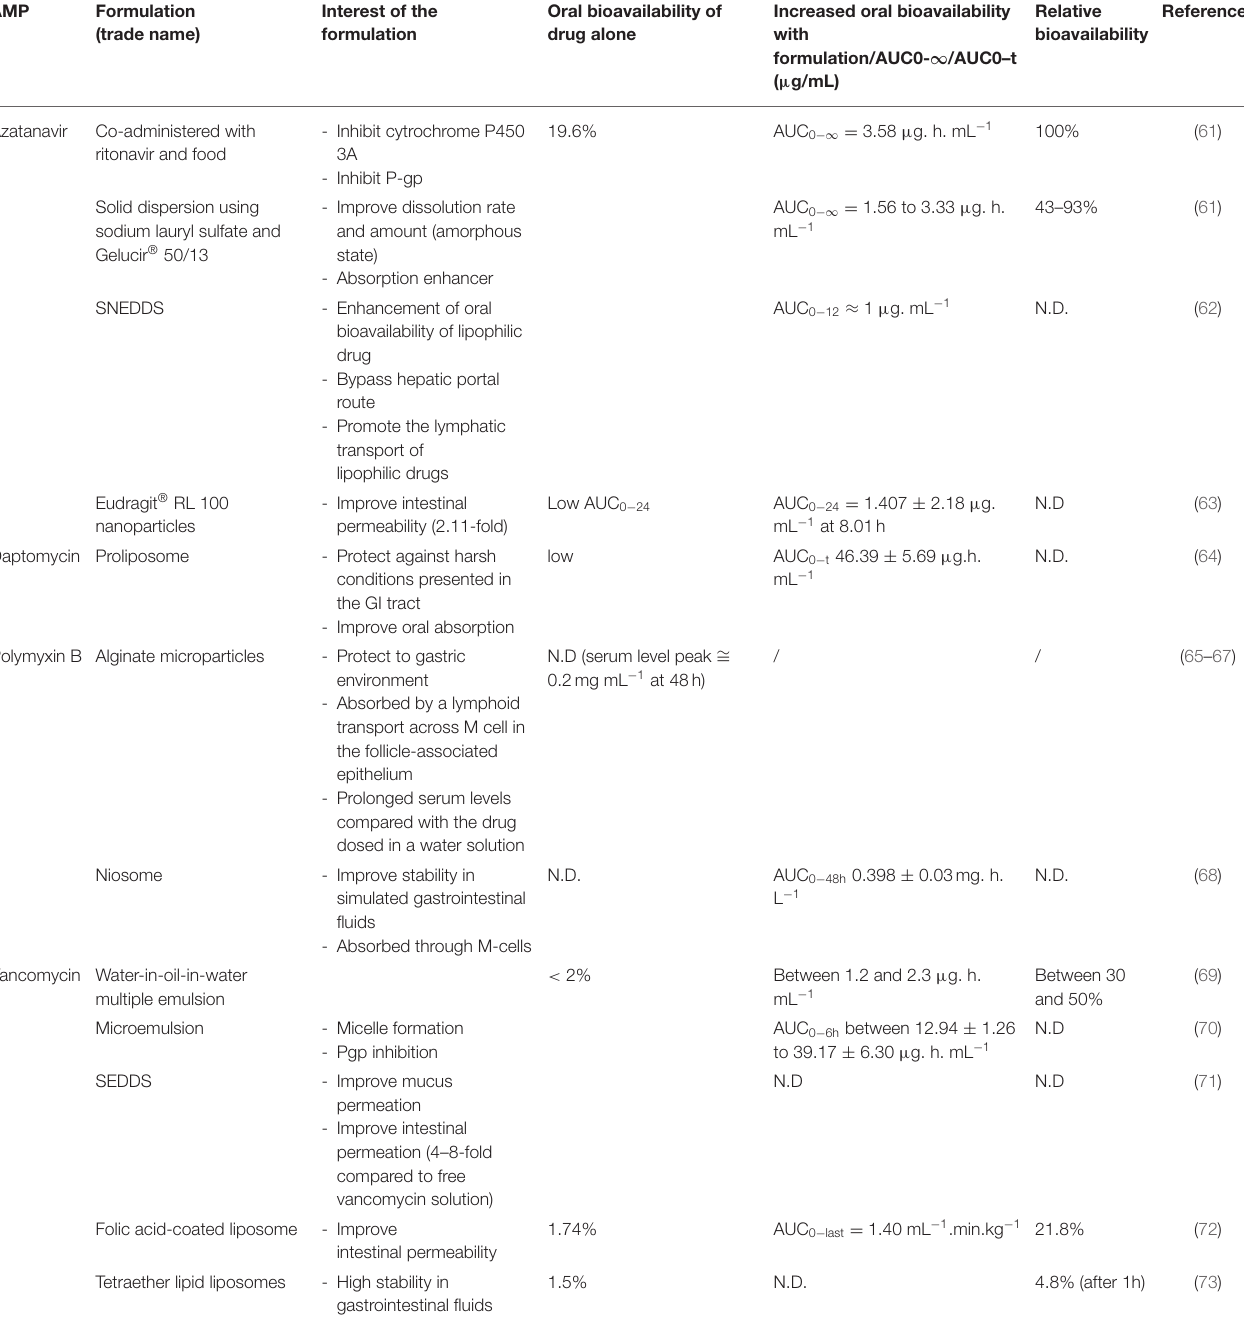
TABLE 2 | Oral AMP formulations to improve